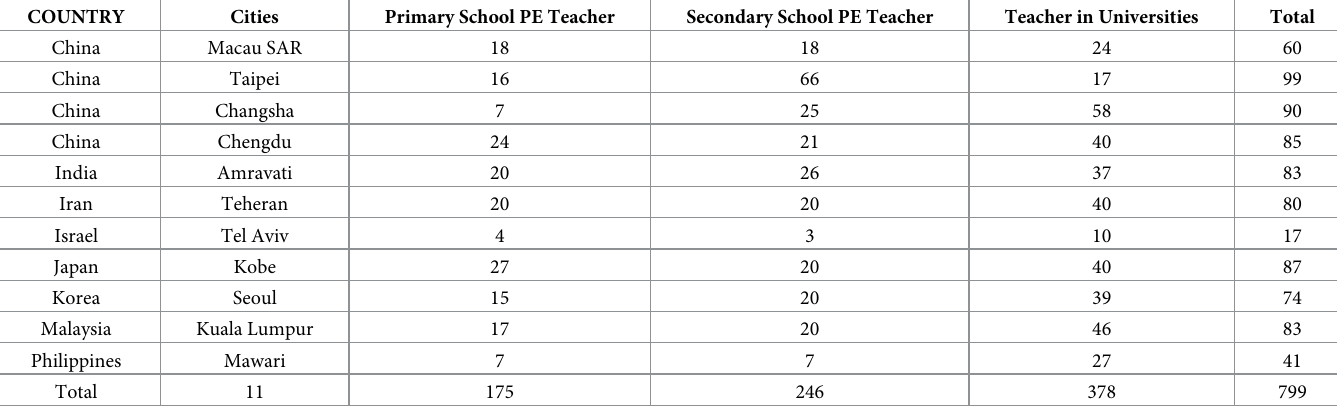
Table 1. Number of participants in the QPE survey in Asia.